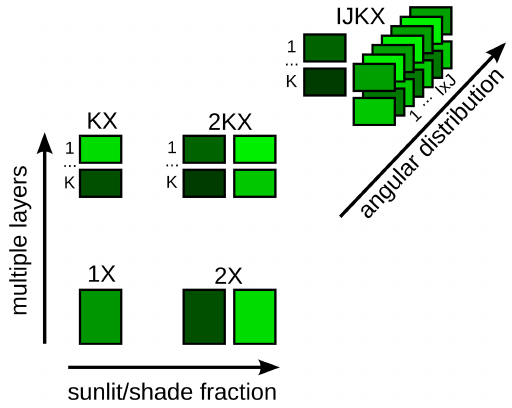
Figure 1. Canopy complexity levels. 1X: single-layer canopy with- out sunlit or shaded fractions. 2X: single-layer canopy with sun- lit and shaded fractions. KX: multiple-layer canopy without sun- lit or shaded fractions. 2KX: multiple-layer canopy with sunlit and shaded fractions per layer. IJKX: multiple-layer canopy with sunlit and shaded fractions per layer, with the sunlit fraction being further partitioned based on leaf inclination and azimuth angular distribu-